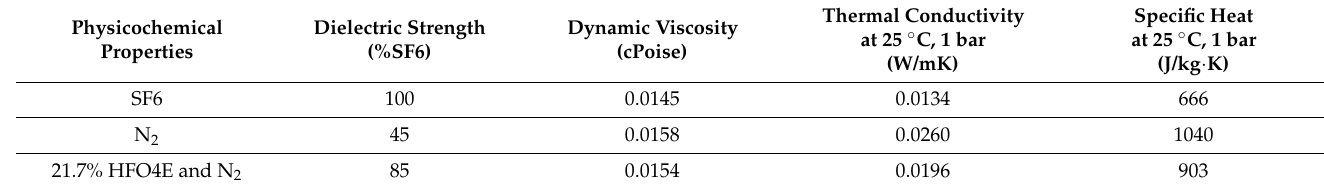
Table 5. Values of dielectric strength, dynamic viscosity, thermal conductivity and specific heat of SF6, N 2 and 21.7% ( v / v ) HFO4E and N 2 gas